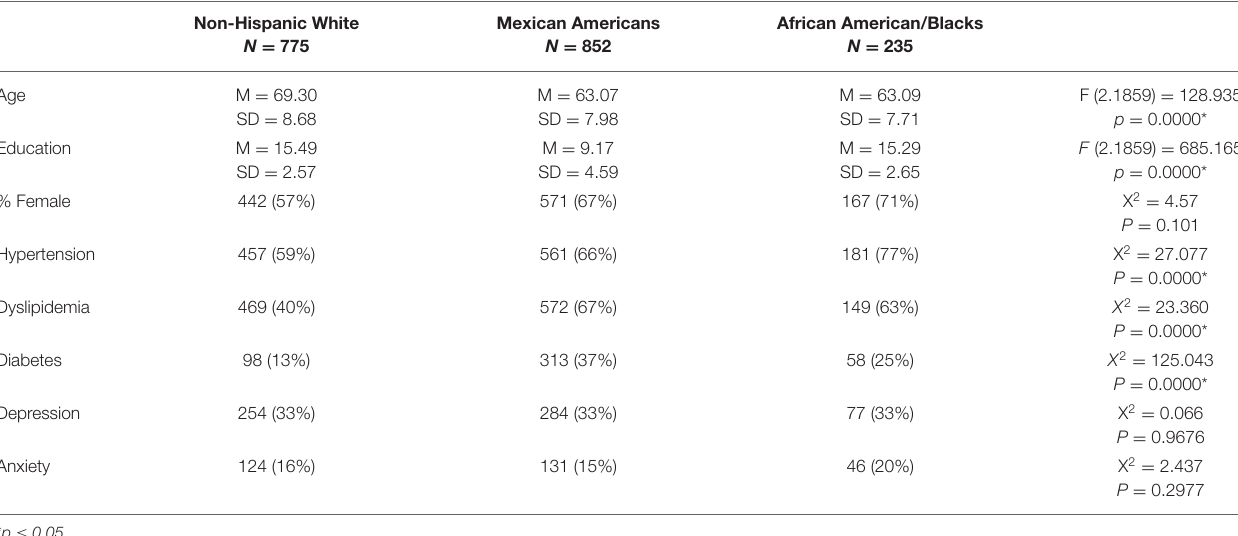
TABLE 1 | Characteristics of the sample.